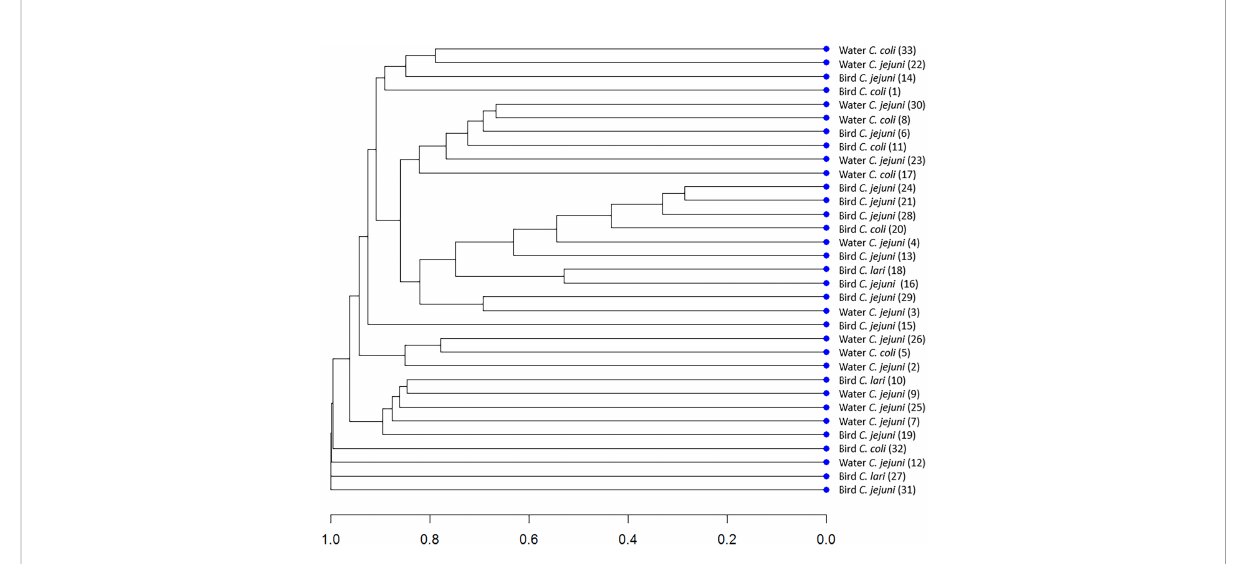
FIGURE 1 Dendrogram determining the degree of genetic dissimilarity of the tested isolates of Campylobacter spp. from water and wild